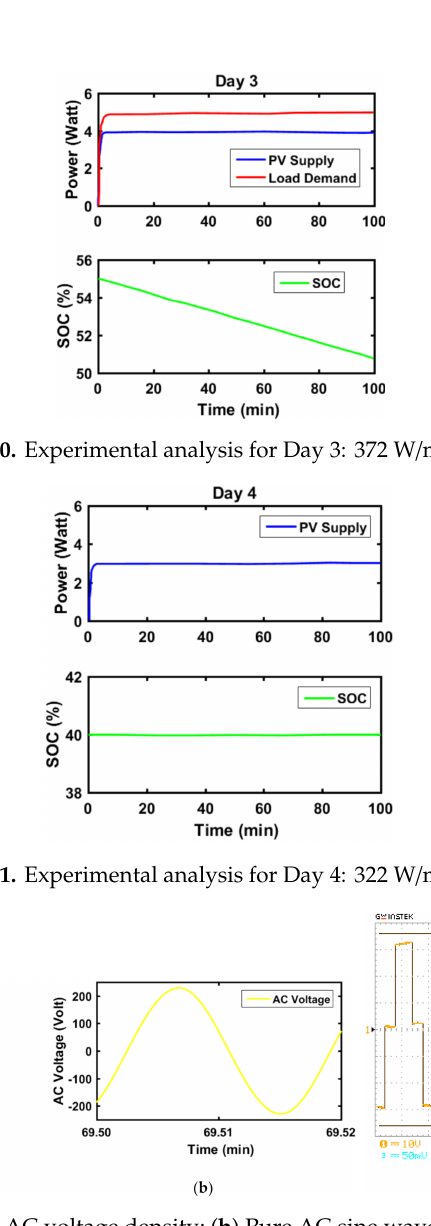
Figure 12. ( a ) Generation of AC voltage density; ( b ) Pure AC sine wave; ( c ) Modified AC sine wave production in